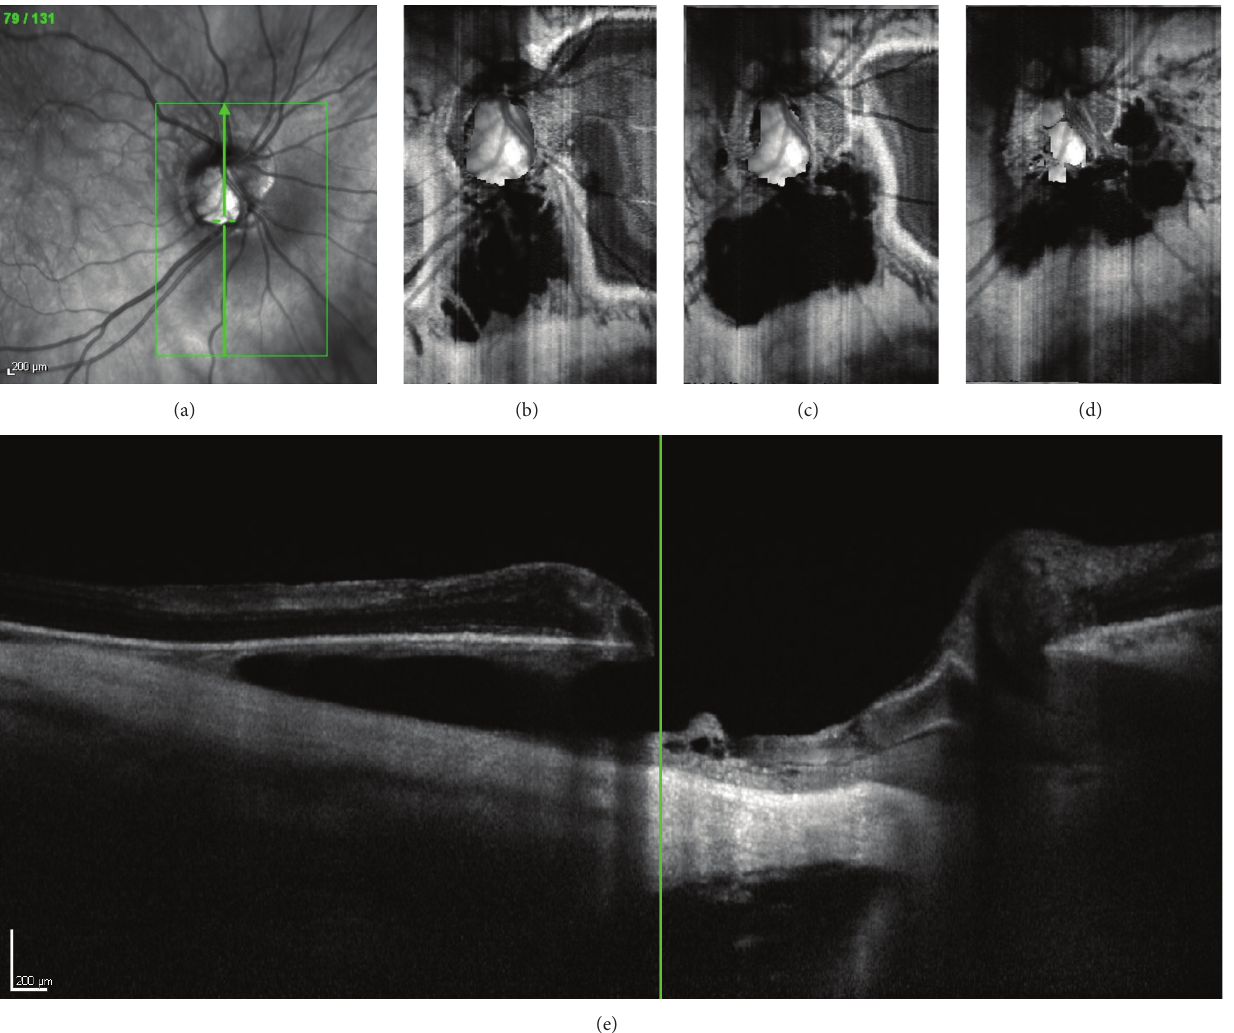
Figure 3: Infrared imaging (a) with localization of B-scan acquisition within the peripapillary cavitation (green arrow). “En-face” Spectral Domain Optical Coherence Tomography (SD-OCT) (b, c, and d) and vertical B-scan through the peripapillary cavitation (e), showing a large intrachoroidal cavitation space separating the retinal pigment epithelium (RPE) from the sclera. Note the lateral “V-shaped” extension of the cavitation inside the choroid on